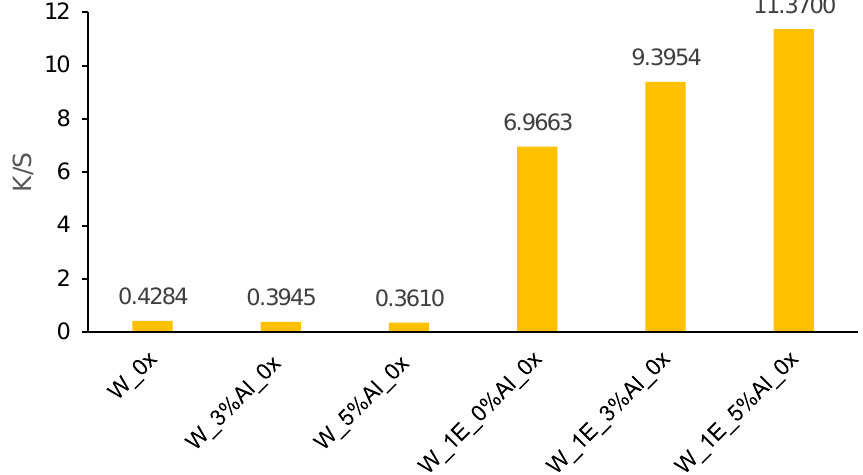
Figure 7. K/S values of wool samples which are untreated (W_0x), treated only with mordants (W_3%Al_0x and W_5%Al_0x) or dyed with (W_1E_3%Al_0x and W_1E_5%Al_0x) and without mordants (W_1E_0%Al_0x).